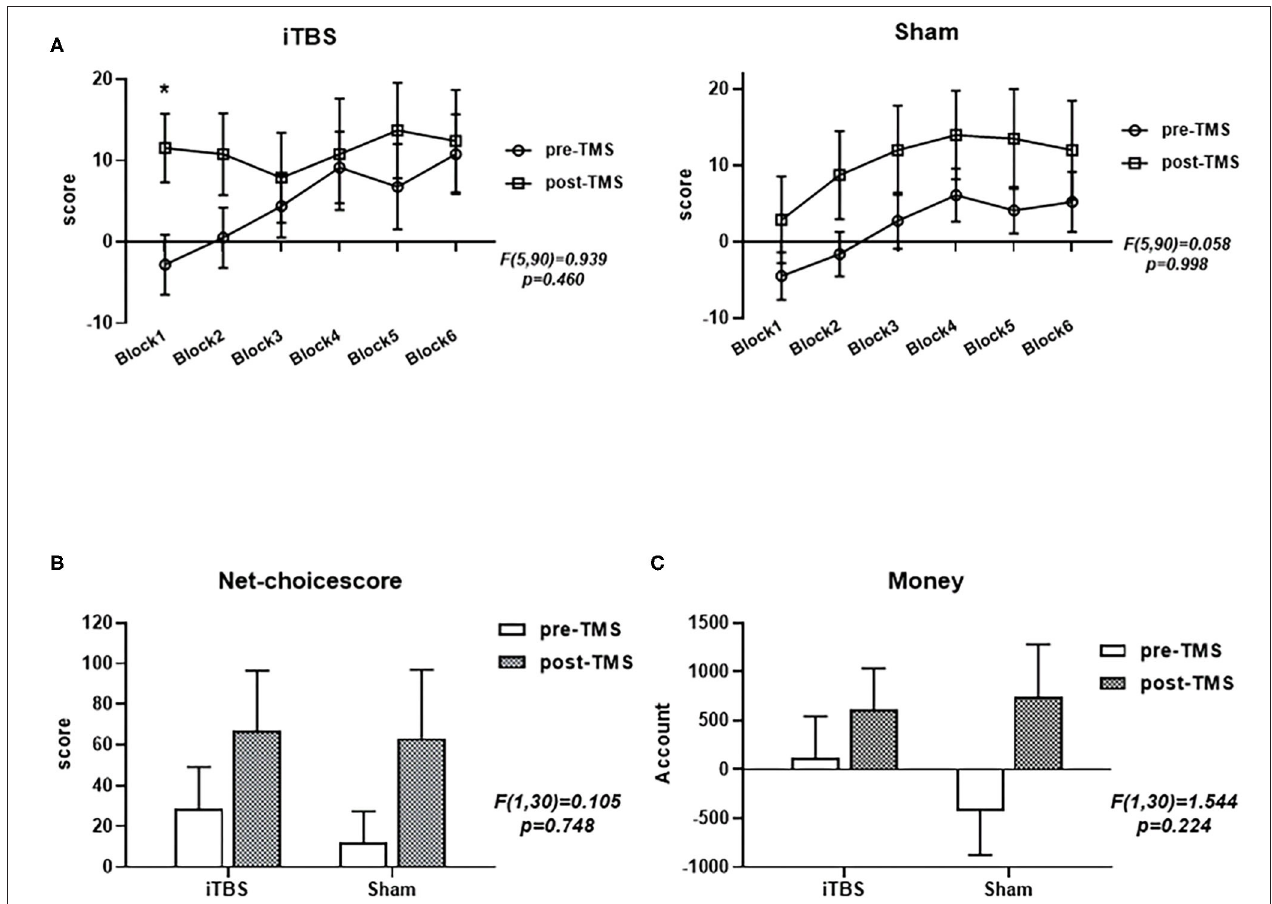
FIGURE 1 | Performance of the intermittent theta burst stimulation (iTBS) and sham groups in the revised Iowa Gambling Test (IGT). Comparisons of the two groups’ net scores on the six blocks (A) , final total net choice scores (B) , and final monetary amount (C) before and after treatment. *** p < 0.001; ** p < 0.01; * p < 0.05; ns: p >